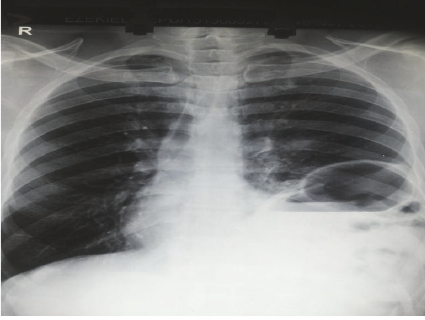
Figure 1: Chest X-ray showing air fluid levels and gastric fundal gas.